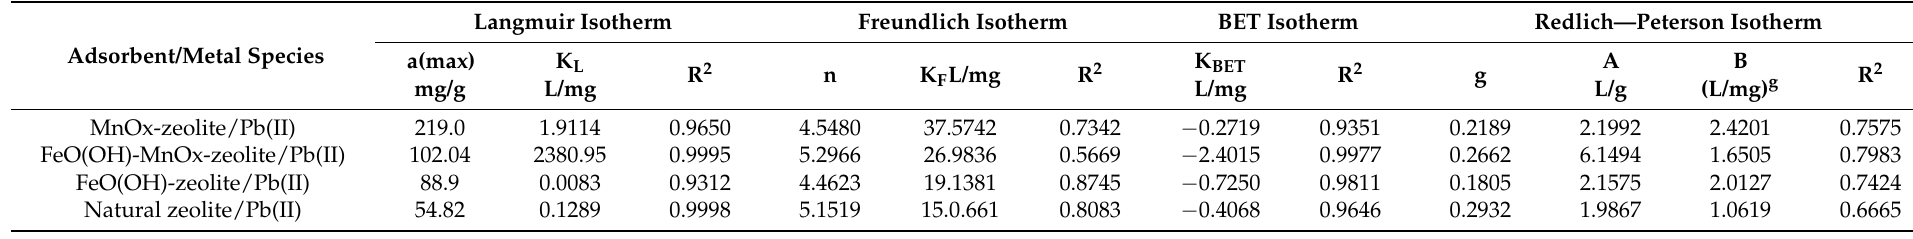
Table 3. Langmuir, Freundlich, BET, and Redlich–Peterson isotherms data for Pb(II) adsorption onto natural, FeO(OH)-, FeO(OH)-MnOx- and MnOx-zeolite.